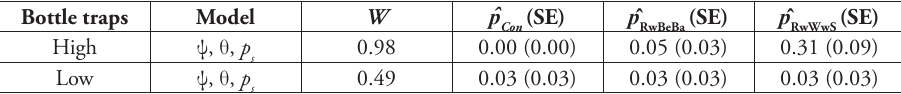
Table 6. Cerambyx cerdo detection probability estimates ( p ̂ ) and associated standard errors (SE) are given for the top models obtained for bottle traps (Con = control; R wine, white wine, sugar) at different heights (High = 10–20 m; Low = 1.5–2 m). w is the Akaike’s weight for each model. Detection/non-detection data were recorded during surveys of 48 bottle traps carried out at Bosco della Fontana between May and July 2014.